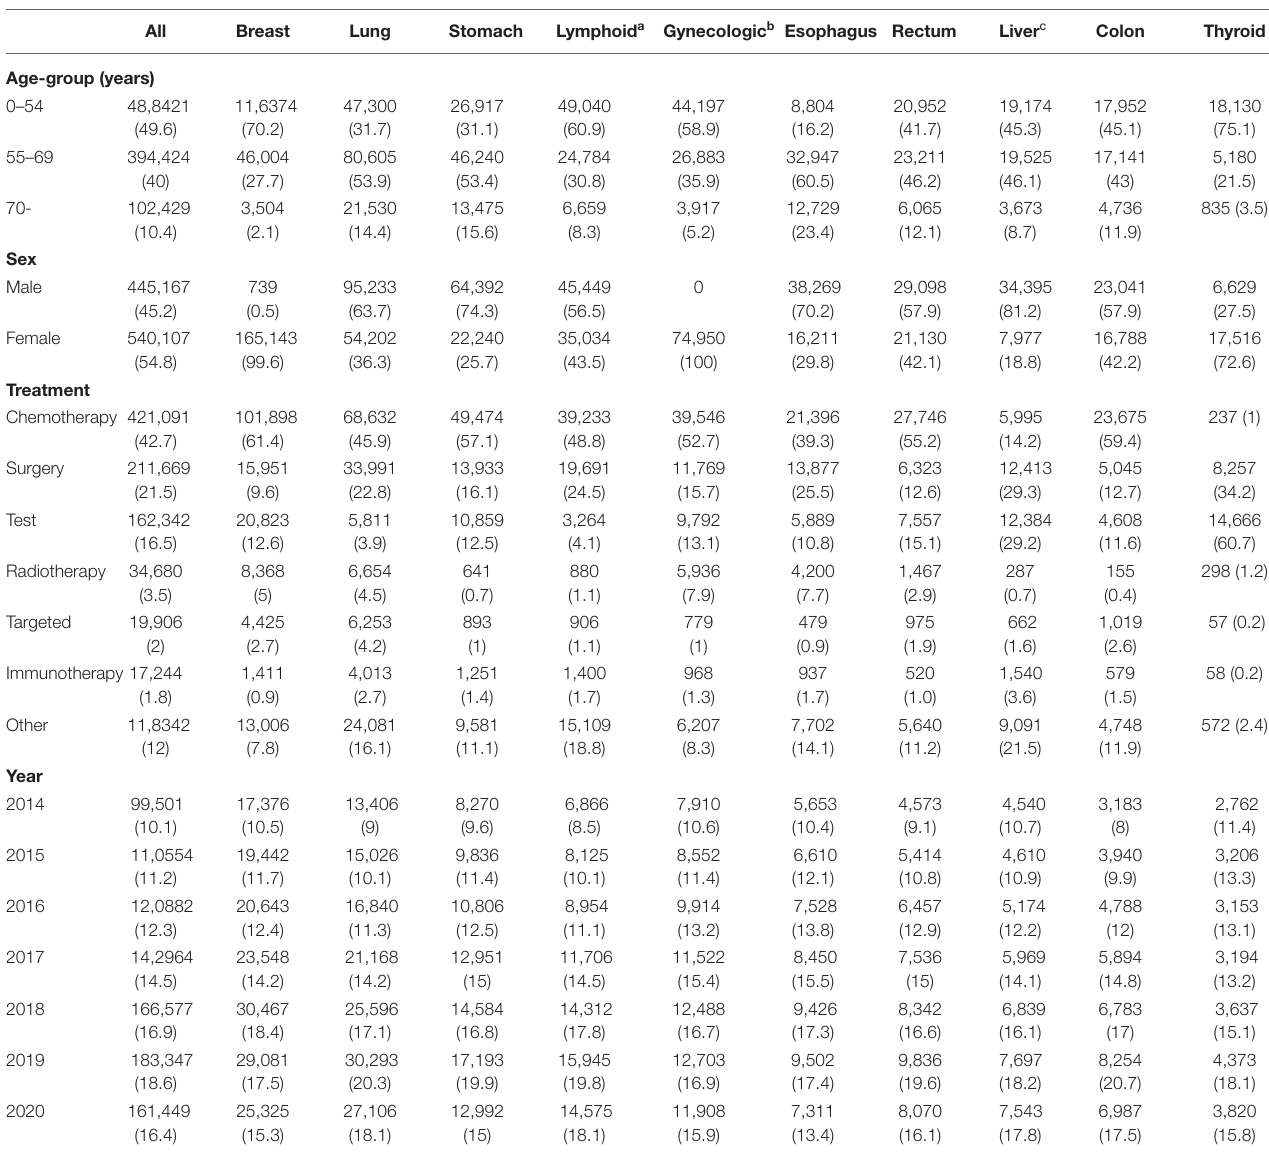
TABLE 1 | Characteristics of inpatients from 2014 to 2020 in Henan Cancer Hospital. All Breast Lung Stomach Lymphoid a Gynecologic b Esophagus Rectum Liver c Colon